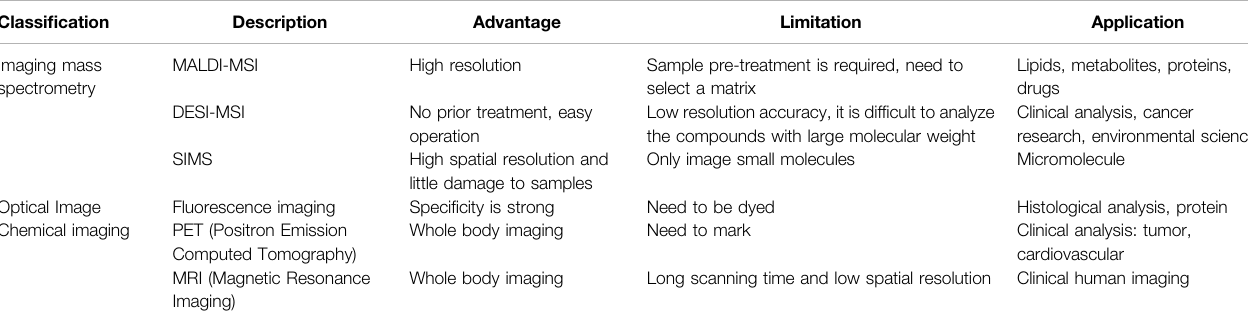
TABLE 1 | Comparison of imaging